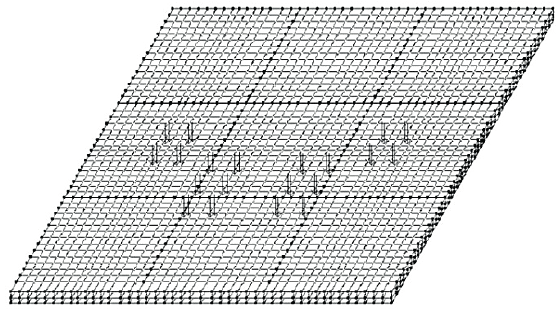
Fig. 1. Finite element model of a two-layer concrete pavement